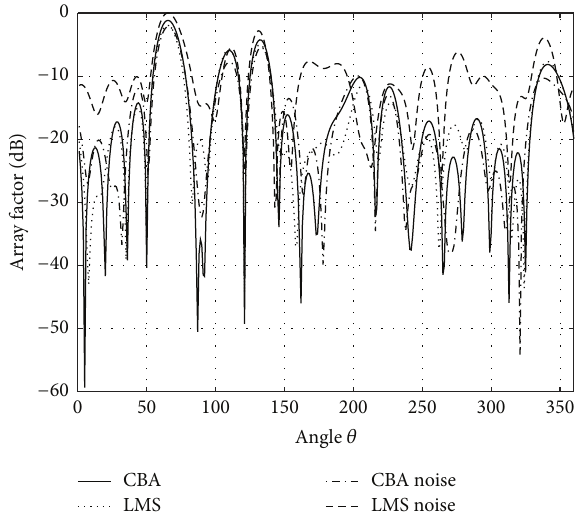
Figure 6: Comparison of the circular array radiation patterns obtained by the Chaotic beamforming algorithm and LMS algo- rithm, shown in plane of azimuthal angle 60 ∘